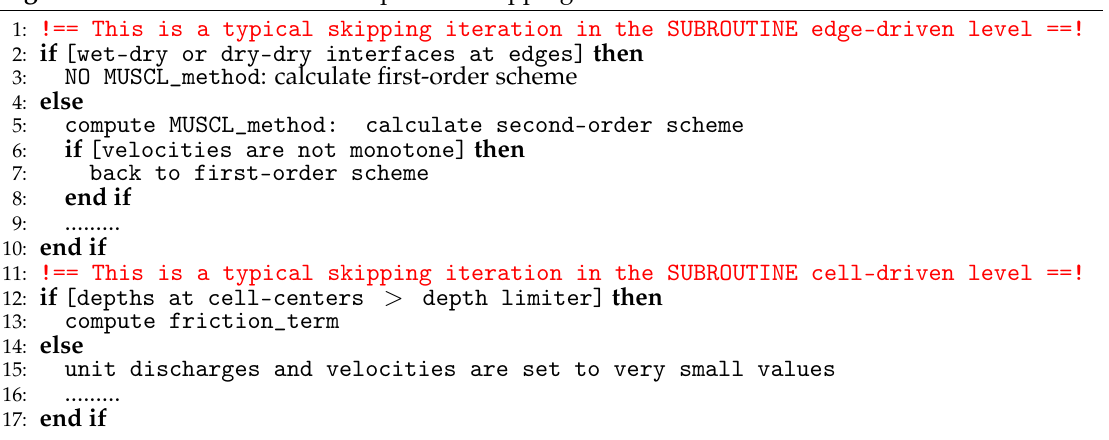
Algorithm 5 Pseudo-code of some possible skipping